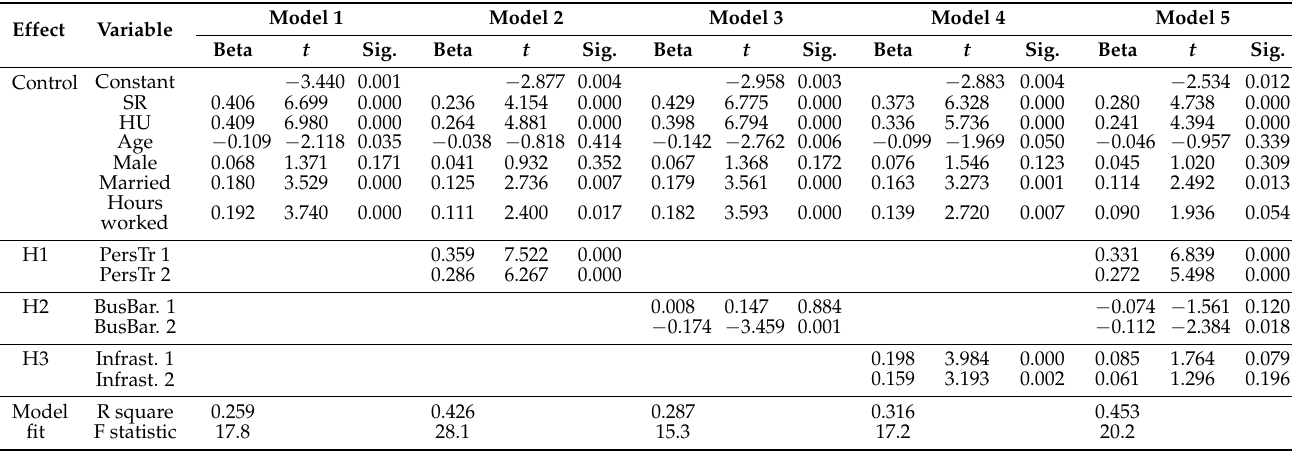
Table 6. Regression